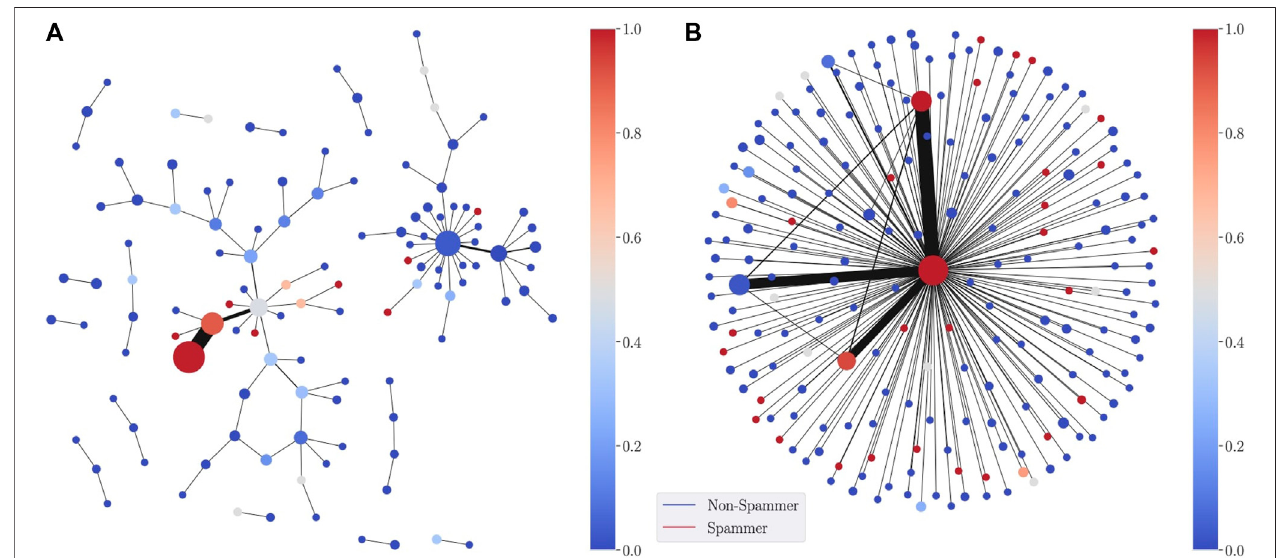
FIGURE8| DGM (A) vsSDGM (B) visualizationofthesytheticspammerdatasets.DGMdoesnotcaptureimportantrelationalinformationbetweenspammersand non-spammers.